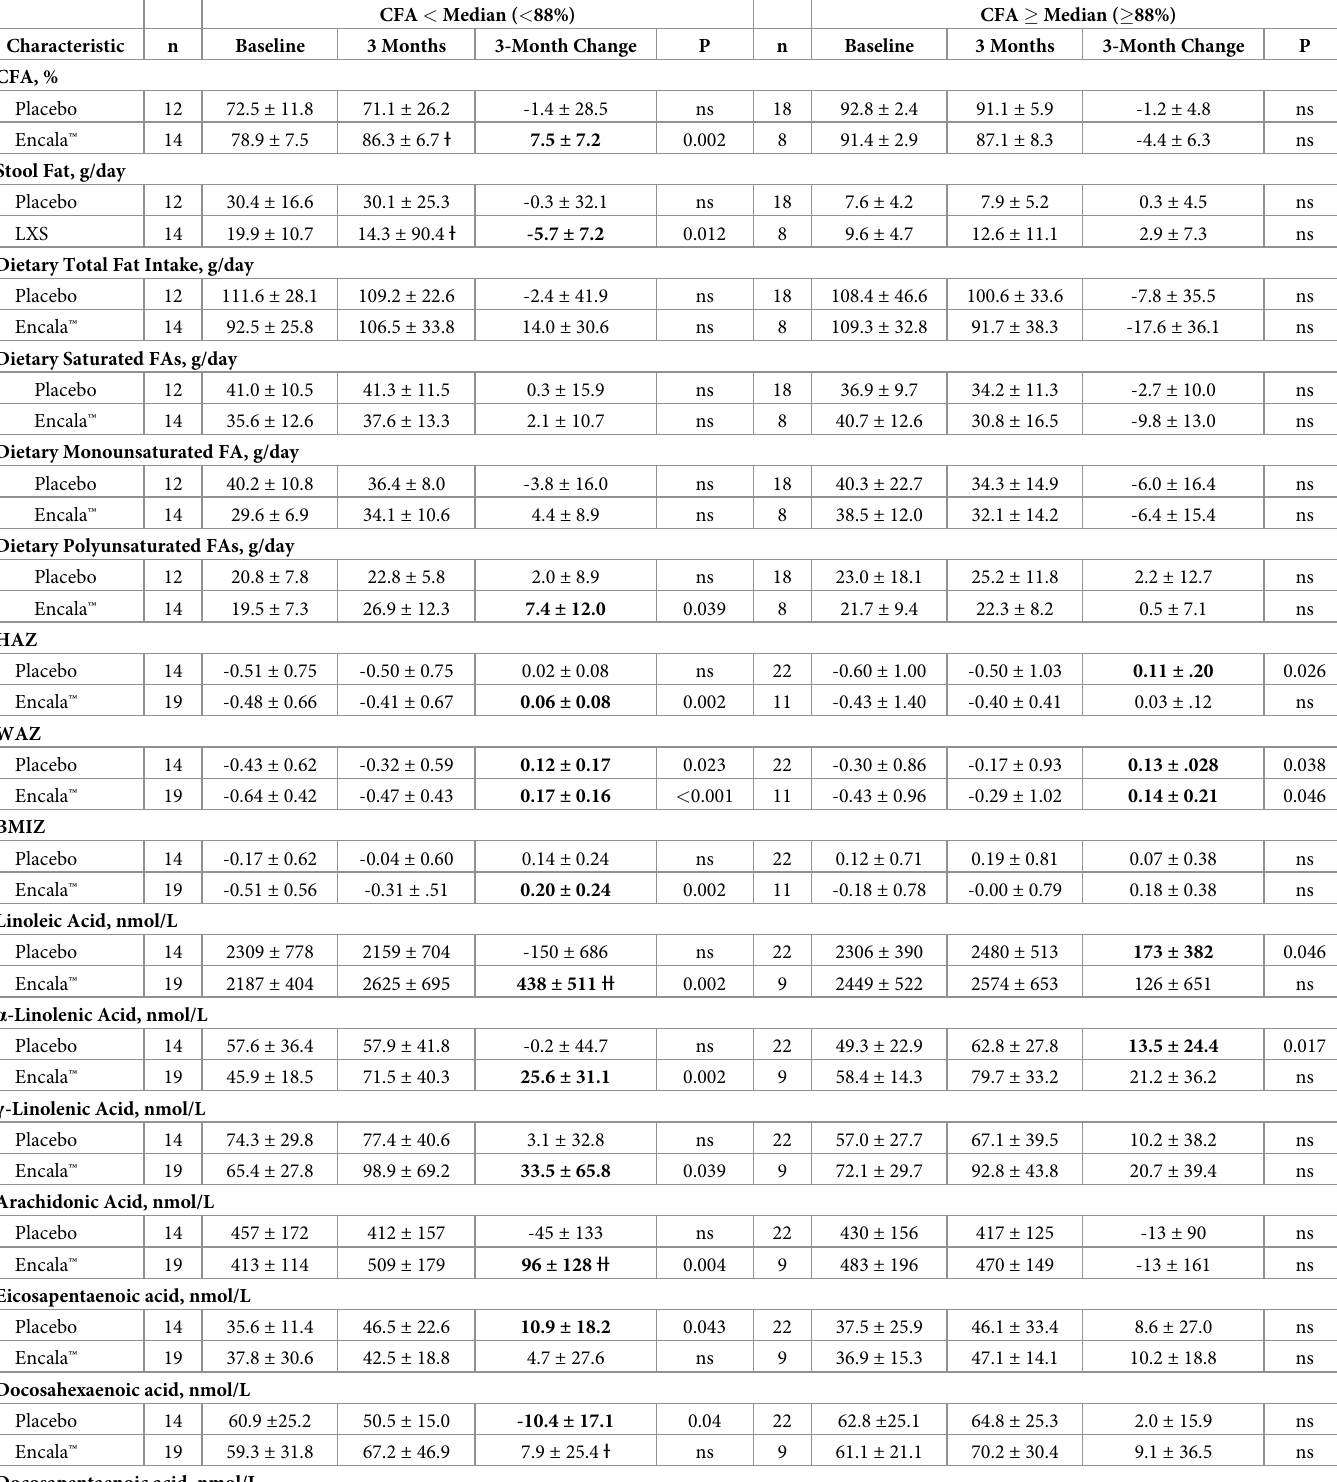
Table 2. Outcomes by coefficient of fat absorption subgroups: Encala ™ vs.